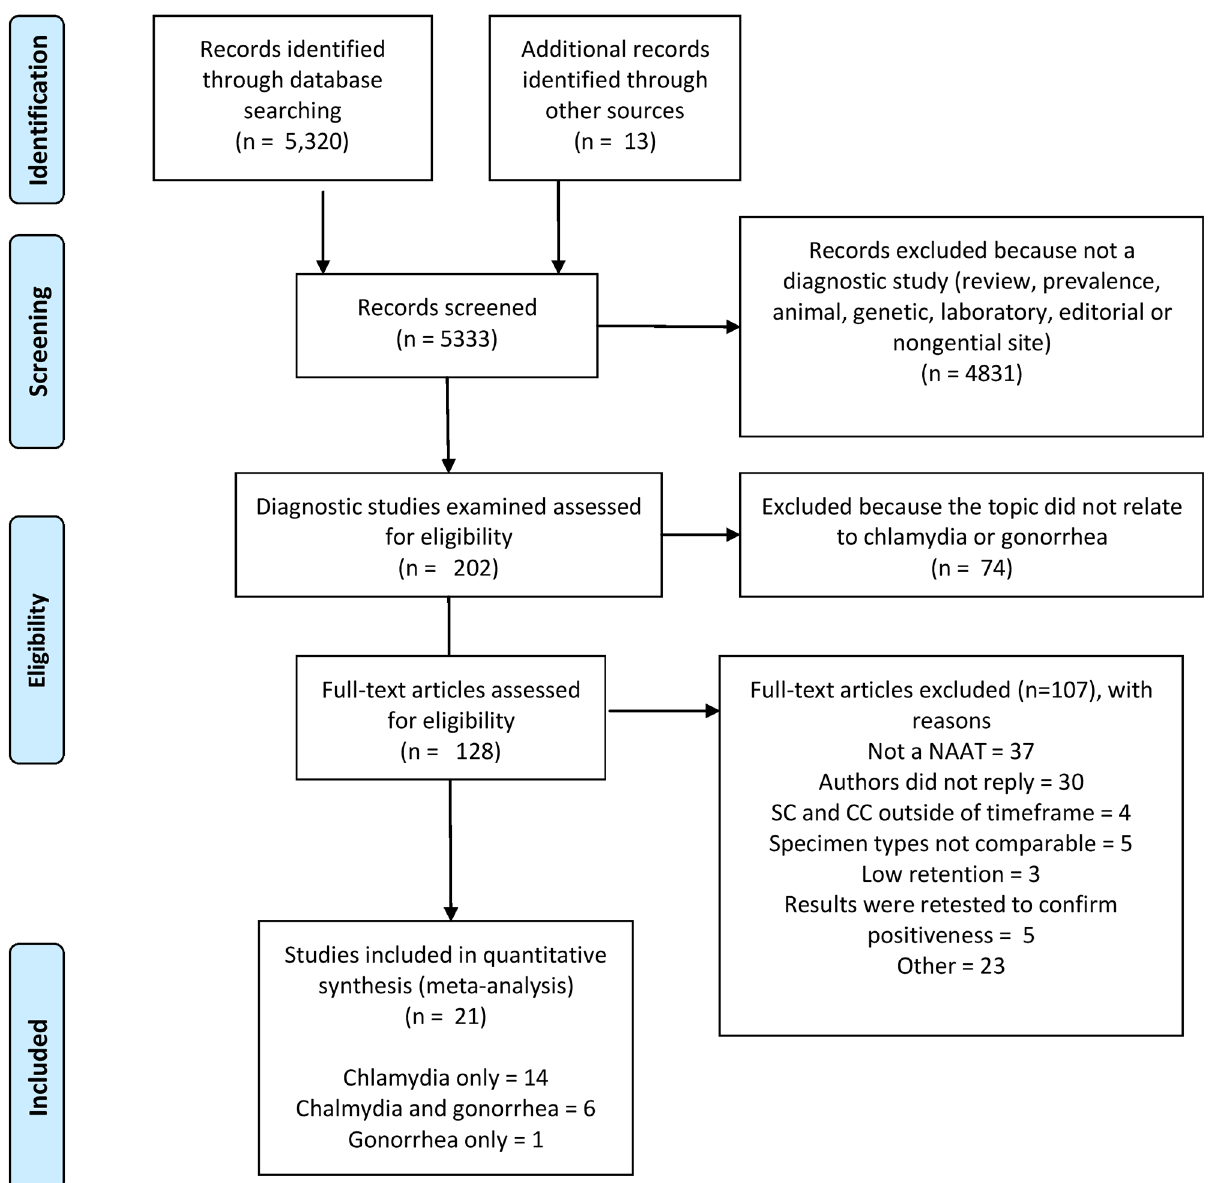
Fig 1. PRISMA flowchart of identification and selection of